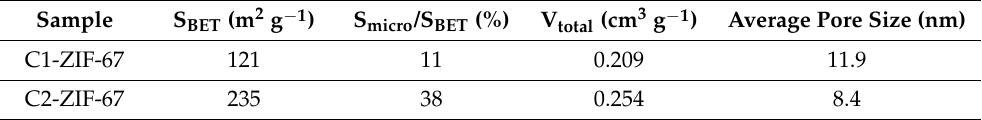
Figure 6. Nitrogen adsorption isotherms ( a ) and the distribution of the pore sizes ( b ) of C1-ZIF-67 and C2-ZIF-67. Table 1. Pore structure parameters of the investigated samples.